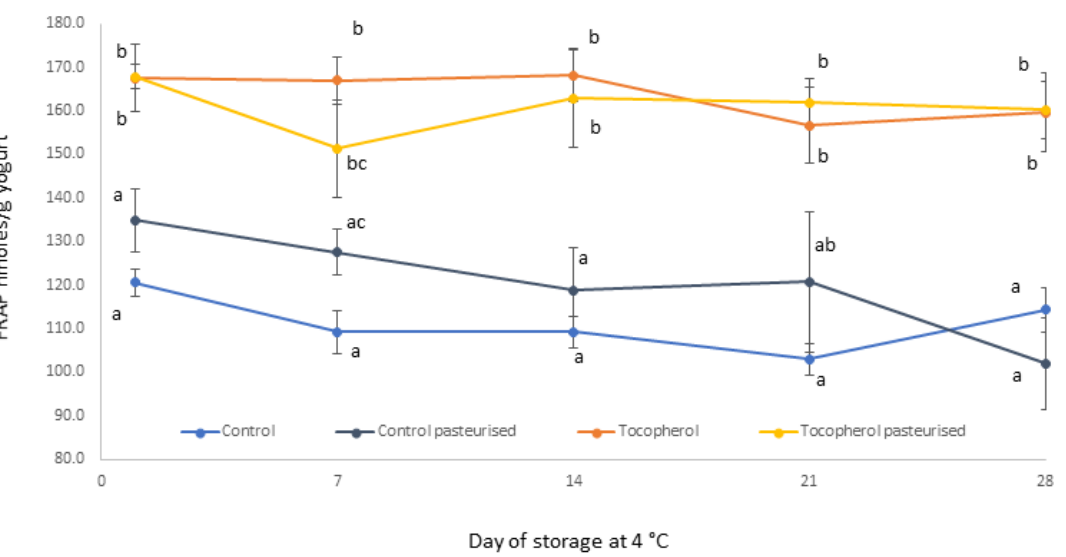
Figure 1. FRAP (ferric reducing antioxidant power) of yogurt-based beverages during cold storage. Results are presented as mean ± SD. Different low case letters denote significant differences at each time point ( p < 0.05).